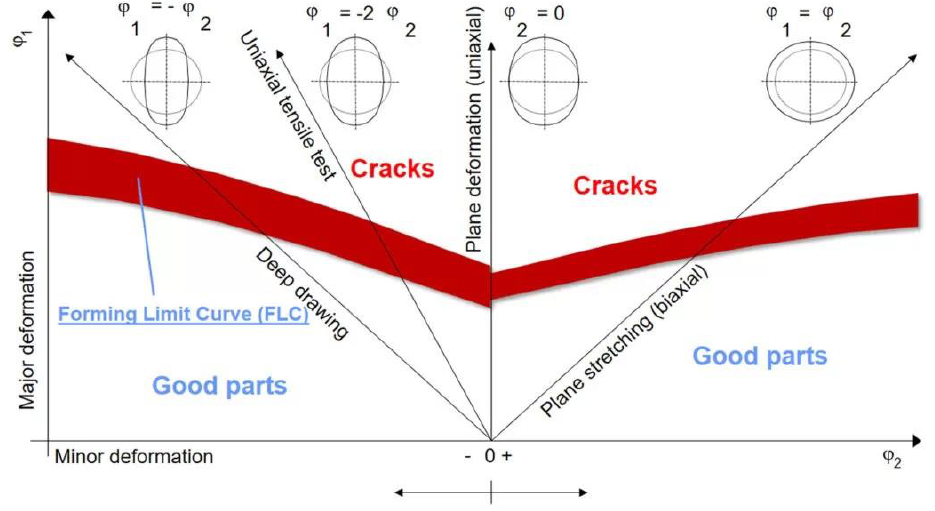
Figure 5. Nakajima probe dimensions and forming limit diagram test (Reproduced with permission from Souza, J. H. C.; published by FormingWorld, 2022 [23])).